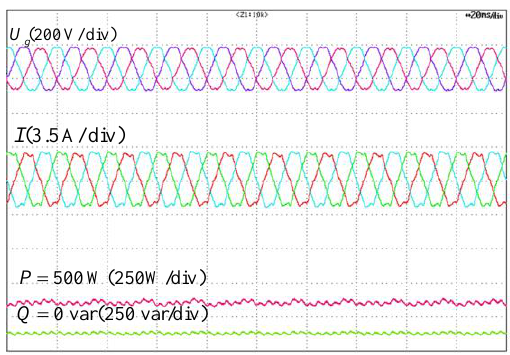
Figure 9. Experiments of VSC under a integer harmonics grid without the proposed control.